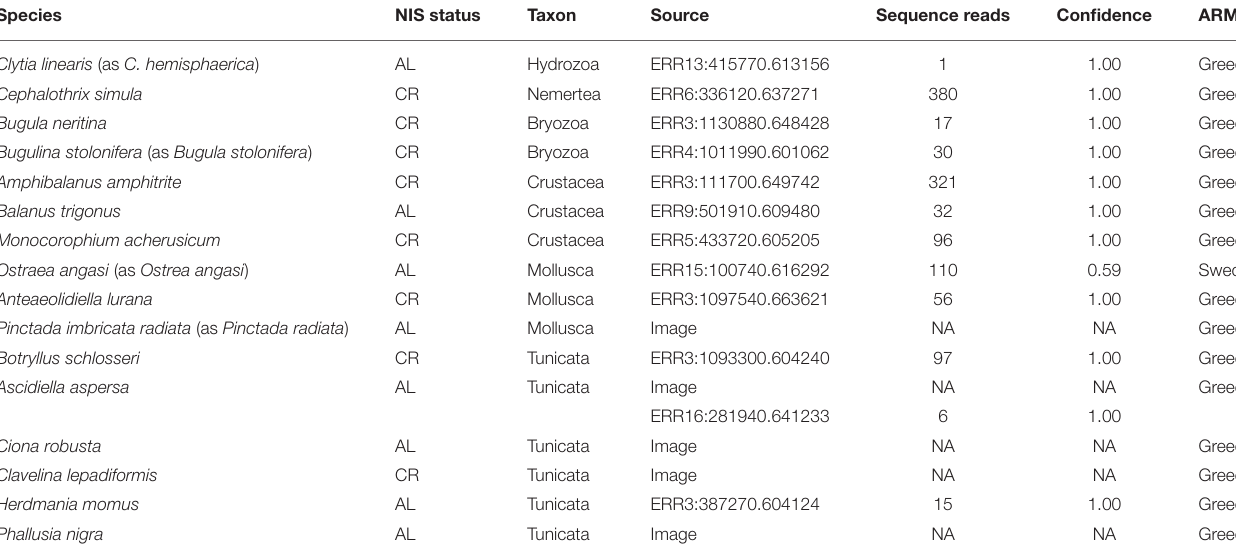
TABLE 1 | List of identified non-indigenous species (NIS) resulting from matching the complete species lists from two samples (Greece ARMS: Crete_1HERP_180928-190128, Sweden ARMS: Koster_VH2_180418-180906) against EASIN and AquaNIS databases.